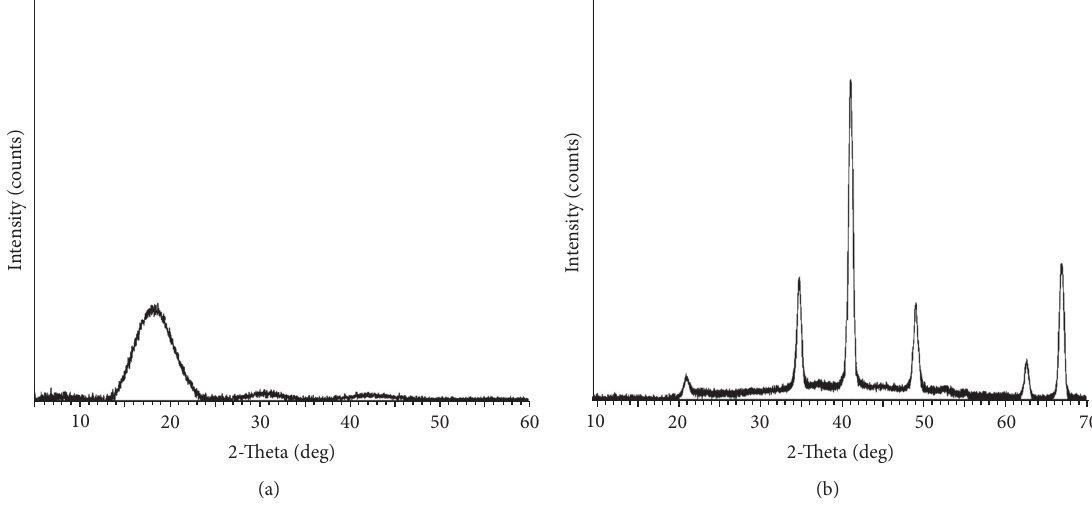
Figure 2: XRD patterns of the PGMA-MAn copolymer and PGMA-MAn/ABSAc@Fe 3 O 4